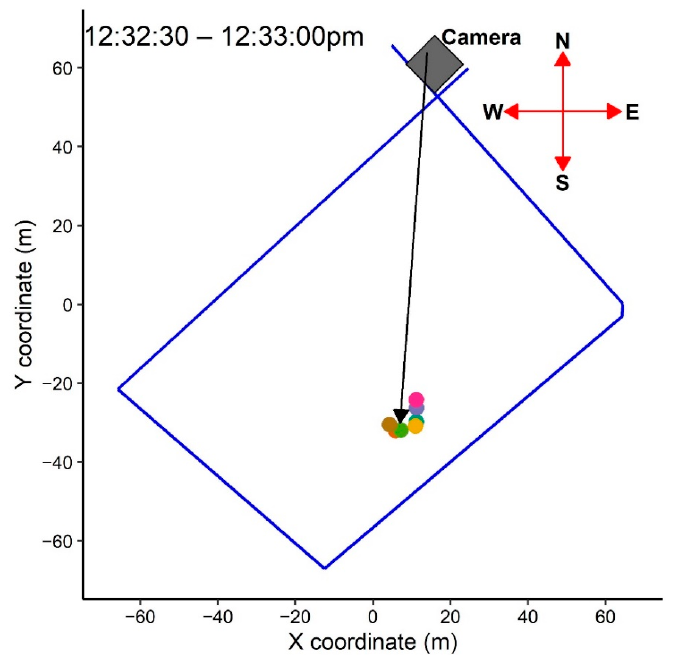
Figure 6. Position of the camera outside of the paddock (the north corner) to record the animals’ movements during parts of the experiment to match the animal position with locational plots and social network graphs (see Section 3.3). Note: The dot points in the plot show the individuals within a 30 s time-period beginning at 12:32:30 p.m.